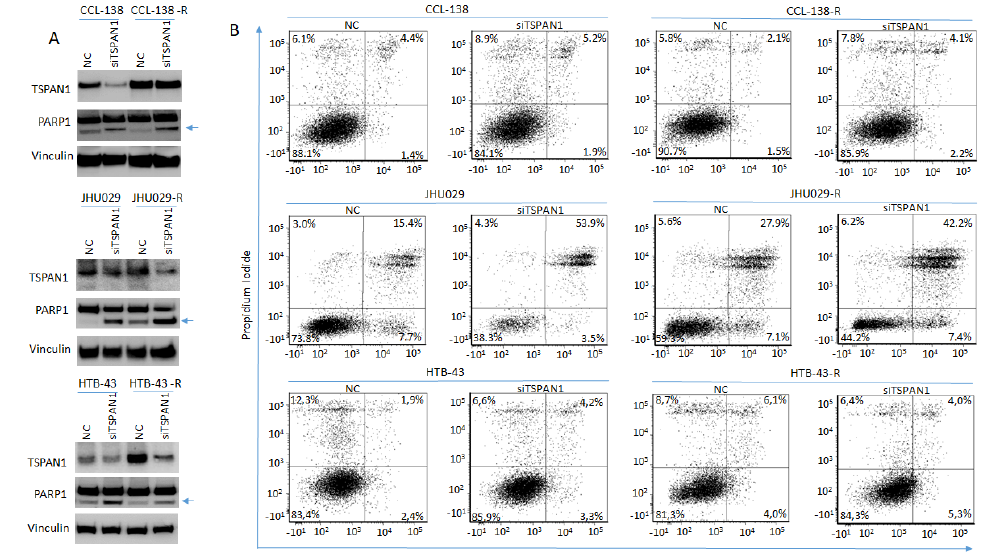
Figure 3. TSPAN1 inhibition induces apoptosis in HNSCC cells. ( A ) Western blot analysis of TSPAN1 and PARP1 cleavage in parental and CDDP-resistant HNSCC cells upon TSPAN1 depletion. In the CCL-138-R cell line, despite not observing TSPAN1 inhibition at protein level (but it was inhibited at the mRNA level), an induction of PARP1 was observed. Note: the lower band corresponds to cleaved PARP1 (arrow). Vinculin was used for protein loading normalization. ( B ) Apoptosis analysis by FACS using Annexin V expression kit. Representative scatter plots of propidium iodide ( y -axis) vs. Annexin V-APC ( x -axis) to detect early (right bottom quadrant) and late (right upper quadrant) apoptosis in parental and their respective CDDP-resistant cells (-R) JHU029, HTB-43 and CCL-138, comparing NC vs. TSPAN1depleted cells.